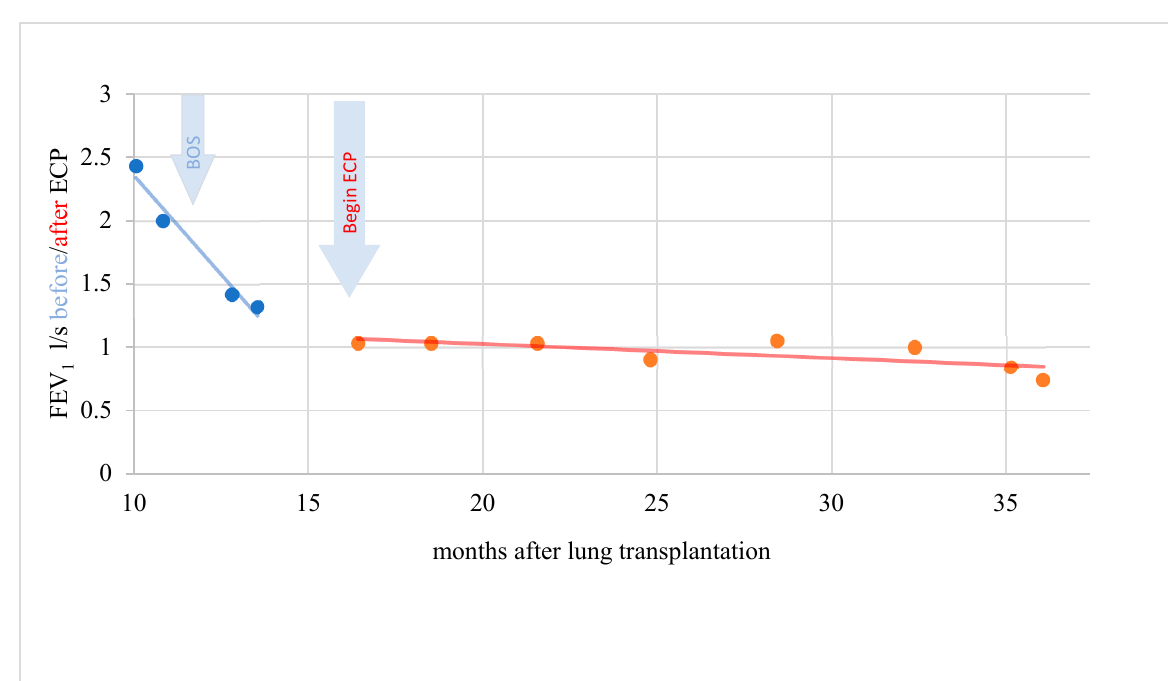
Figure 5. BOS patient with objectifiable but not significant response during ECP. In a patient without response, the rapidity of FEV1 decrease was reduced only mini- mally under ECP being statistically not significant (t = − 0.361; p = 0.722) (Figure 6).